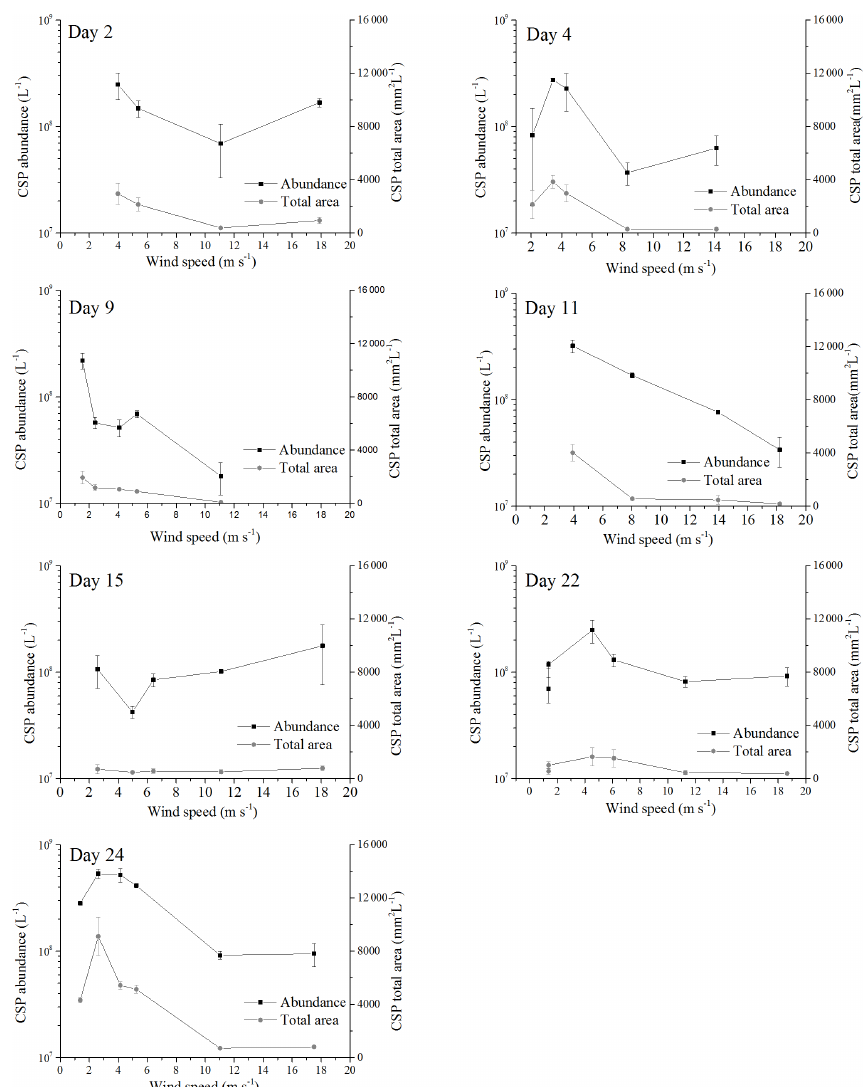
Figure 3. Response of abundance and total area for CSP SML to increasing wind speeds; the error bars indicate ±